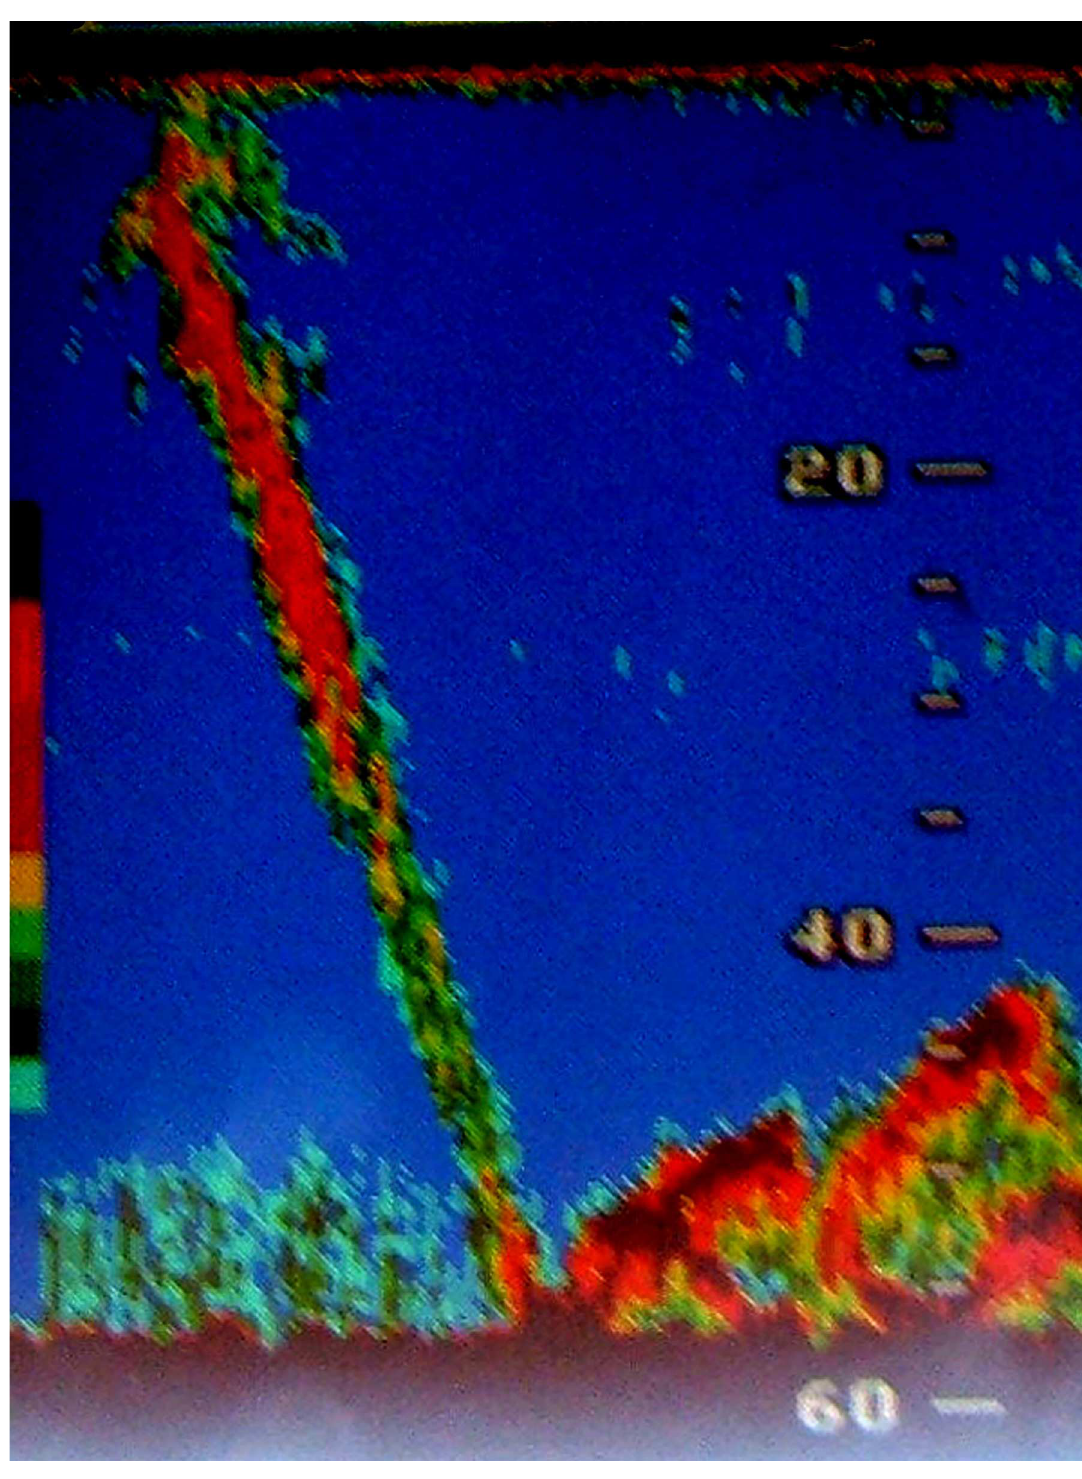
Fig 4. Photograph of a RHIB sonar echogram showing the trail of a diving whale to the seafloor within the dedicated observation of three whales on the edge of a “super-group” at 32.57˚S; 18.048˚Eon 14 November2011 (Observation 3 in Table